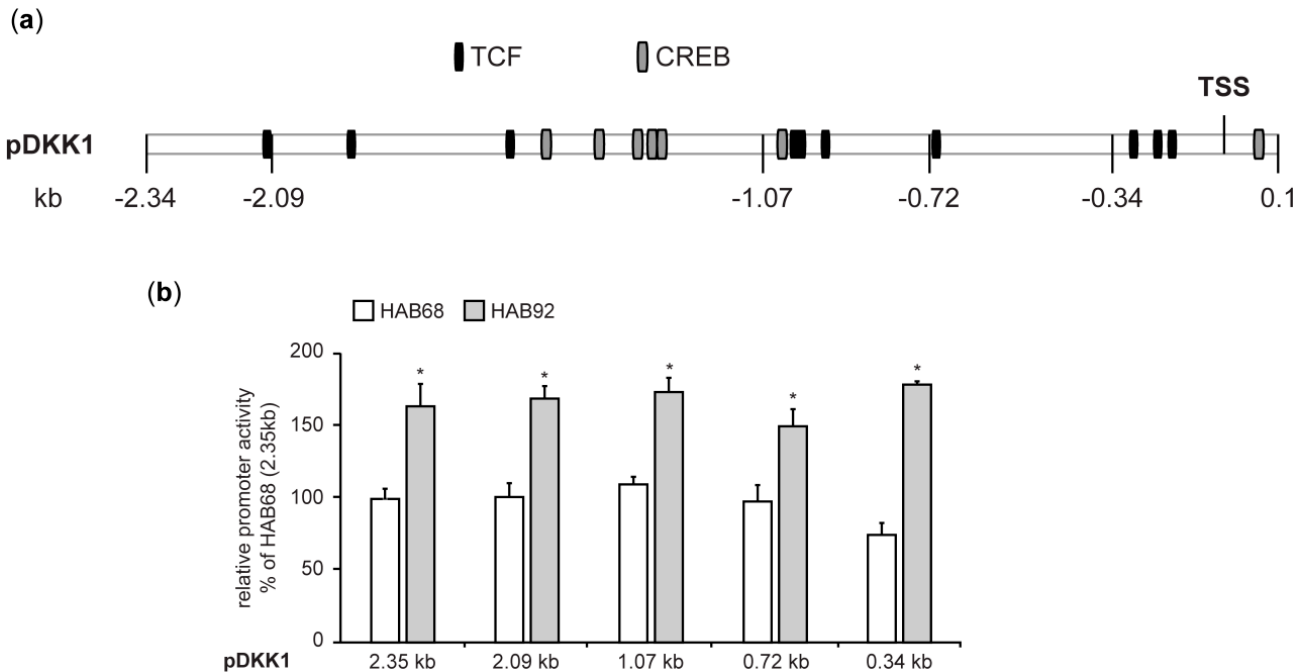
Figure A1. Expression regulation of DKK1 in HAB68 and HAB92 cells occurs near the transcription start site. ( a ) Graphical representation of the human DKK1 promoter. Predicted binding sites of transcription factor complexes containing TCF and CREB-family members are indicated in black and grey, respectively. ( b ) Relative DKK1 promoter-driven luciferase activity in HAB68 cells is significantly lower for all DKK1 promoter constructs compared to HAB92 cells. * statistically significant.